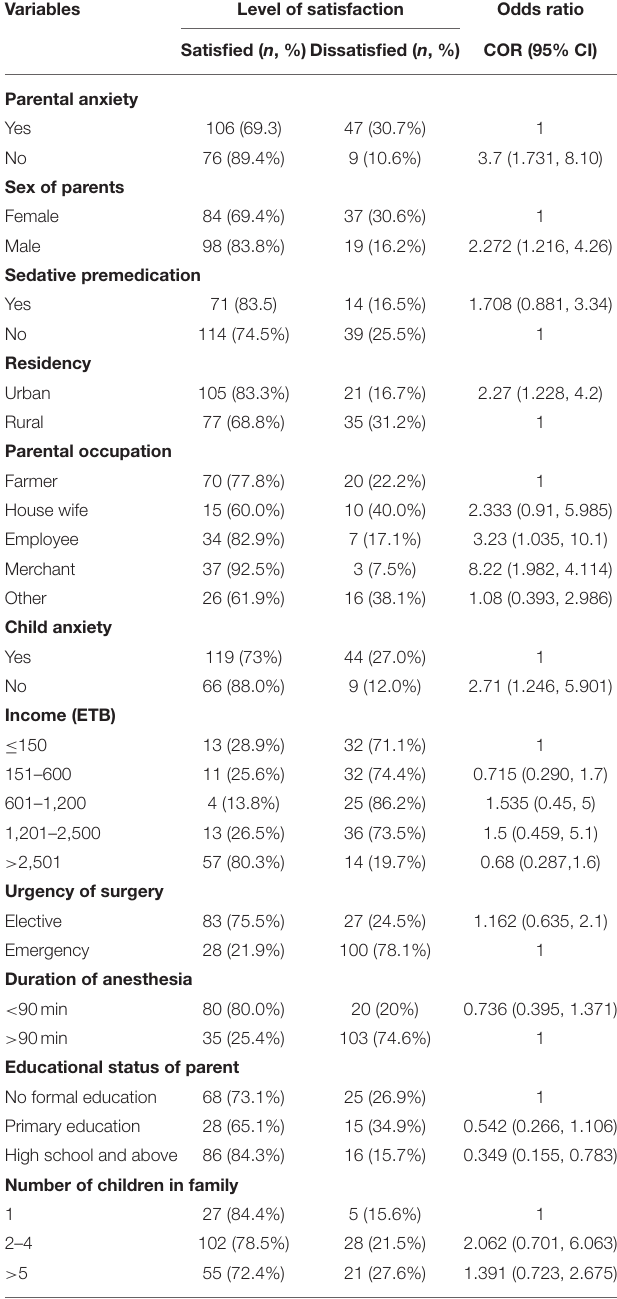
TABLE 4 | Bi-variable logistic regression analysis of factors associated with parental satisfaction toward their child’s anesthesia service, N = 238, 2021.